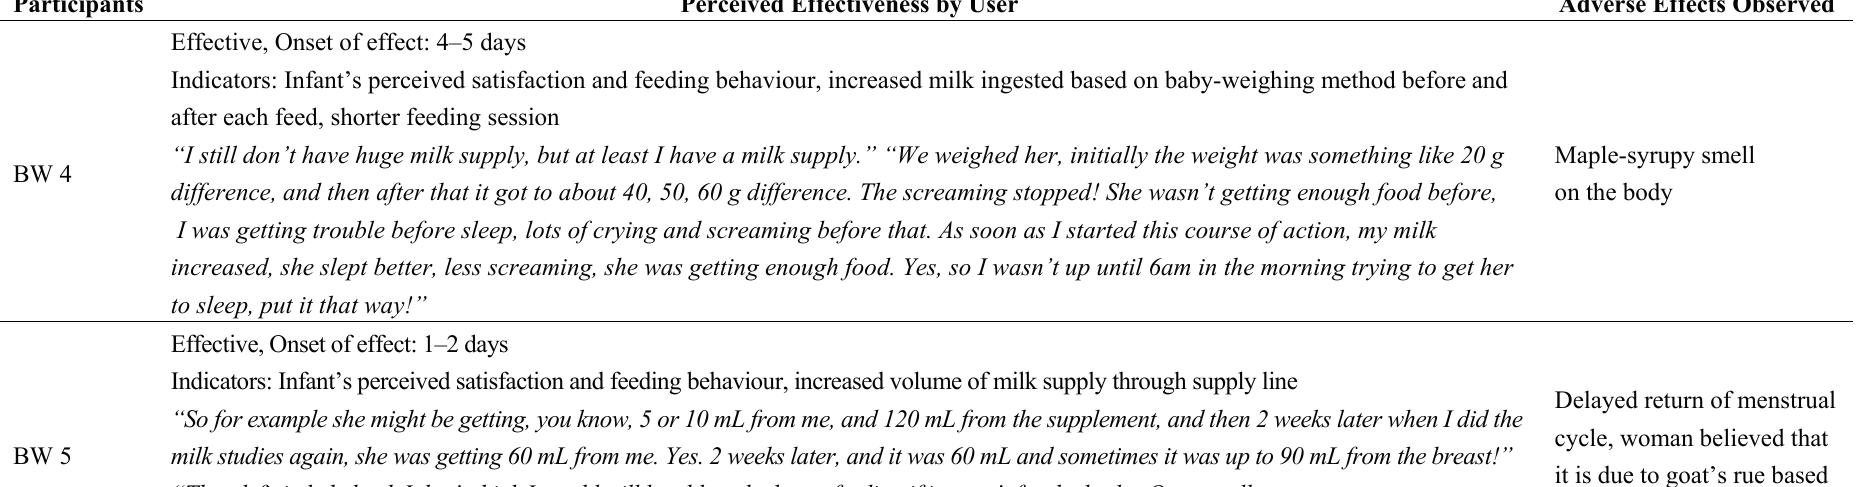
Table 6. Perceived effectiveness and safety: naturopaths’ own “lactation tincture” with a combination of herbal ingredients. Participants Effective, Onset of effect: 4–5